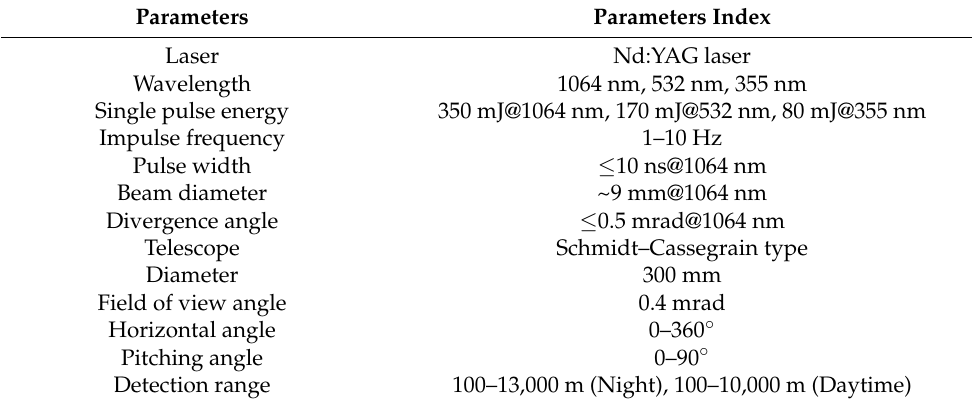
Table 6. The system parameters of Mie scattering